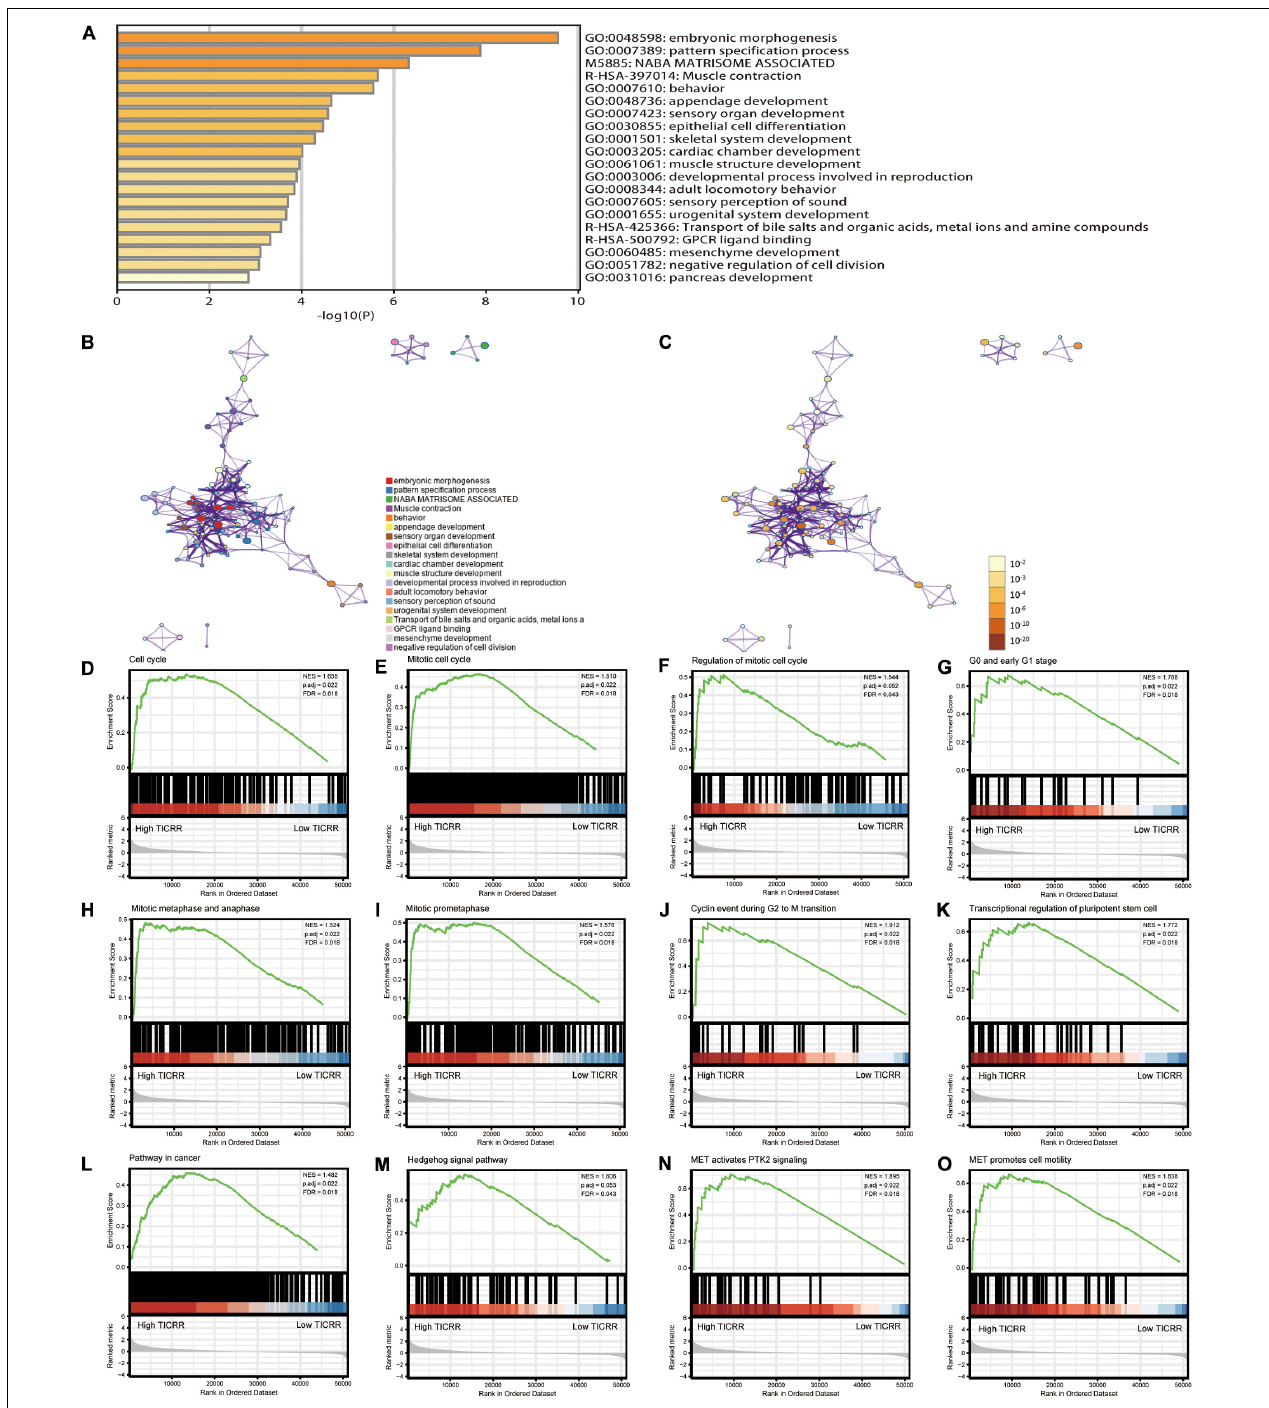
FIGURE 2 | Functional annotation of differentially expressed genes (DEGs) in papillary renal cell carcinoma (PRCC) patients with distinct TICRR levels. According to the Metascape database, 691 differentially expressed mRNAs between high- and low- TICRR expression groups were used for functional annotation. All statistically enriched terms were identified and then hierarchically clustered into a tree (A) based on the threshold of kappa score as 0.3. Representative terms from the cluster were converted into a network layout (B) . The size of a node is proportional to the number of input genes that fall into that term, and the respective color represents its cluster identity. Terms with a similarity score > 0.3 are linked by an edge (the thickness of the edge represents the similarity score). The same enrichment network presents nodes colored by the P -value (C) . (D–O) Representative Gene Set Enrichment Analysis of differentially expressed mRNAs between high- and low- TICRR expression